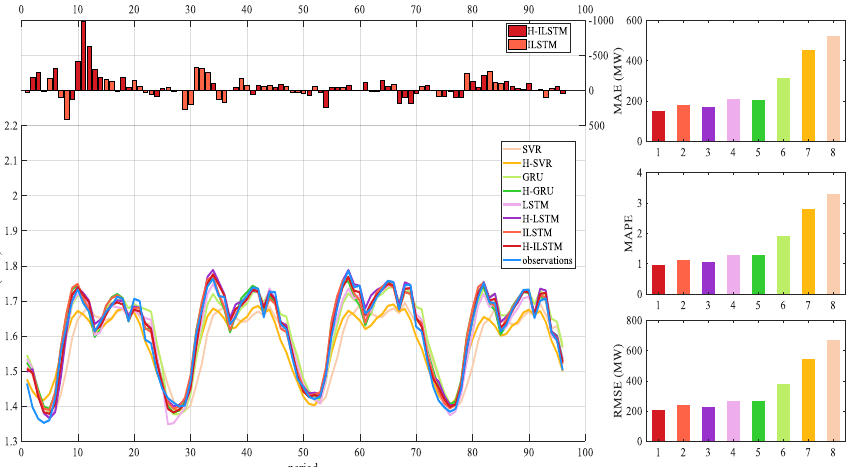
Figure 12. The use of hybrid feature selection has greatly improved the model prediction, and the relative value of each prediction evaluation index of the ILSTM model is shown in Table 10. Compared with not using the hybrid feature selection method, the average Mean Absolute Error (MAE) predicted by this method is improved by 23.8, Mean Absolute Percentage Error (MAPE) is improved by 21.6, and Root Mean Square Error (RMSE) is improved by 23.9. Based on this, it shows that this feature extraction method plays an important role in two-step prediction.